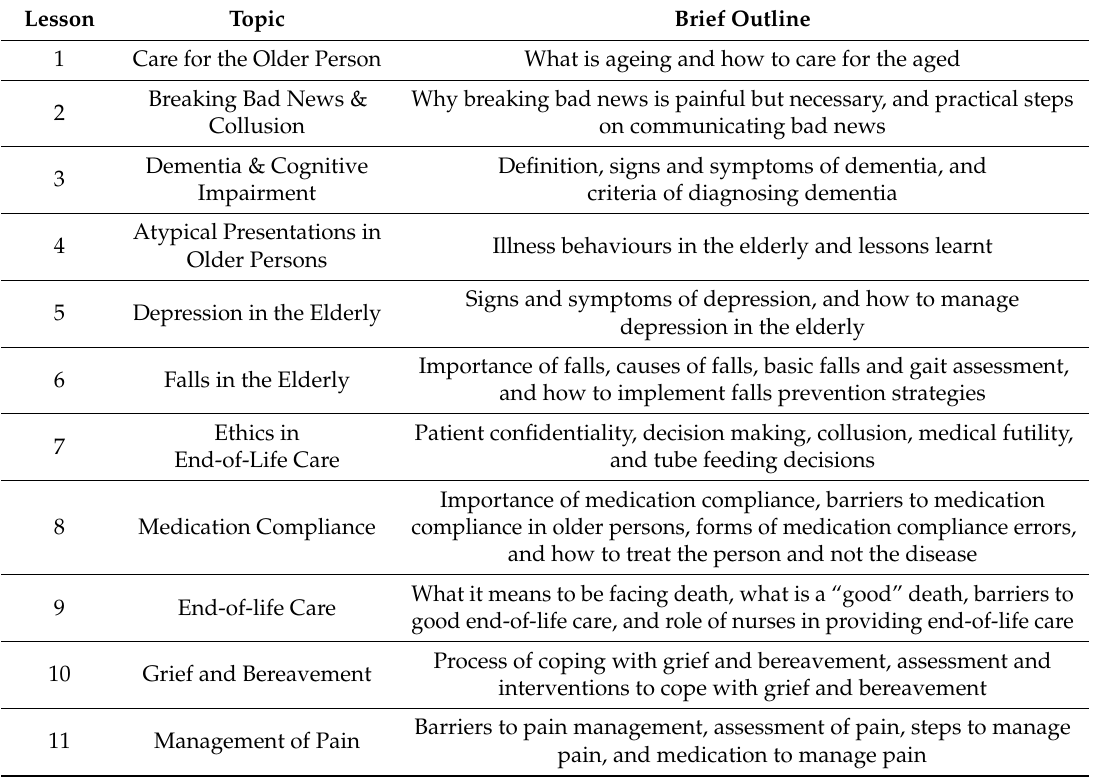
Table A1. Schedule for the Geriatric Education Distance Training Programme.